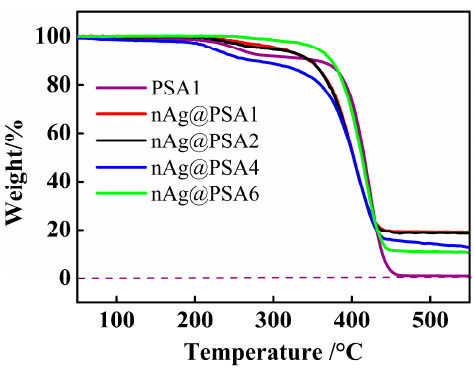
Figure 15. TG curves of PSA nanospheres and nAg@PSA composite nanospheres obtained from PSA1, PSA2, PSA4, PSA6 nanospheres.